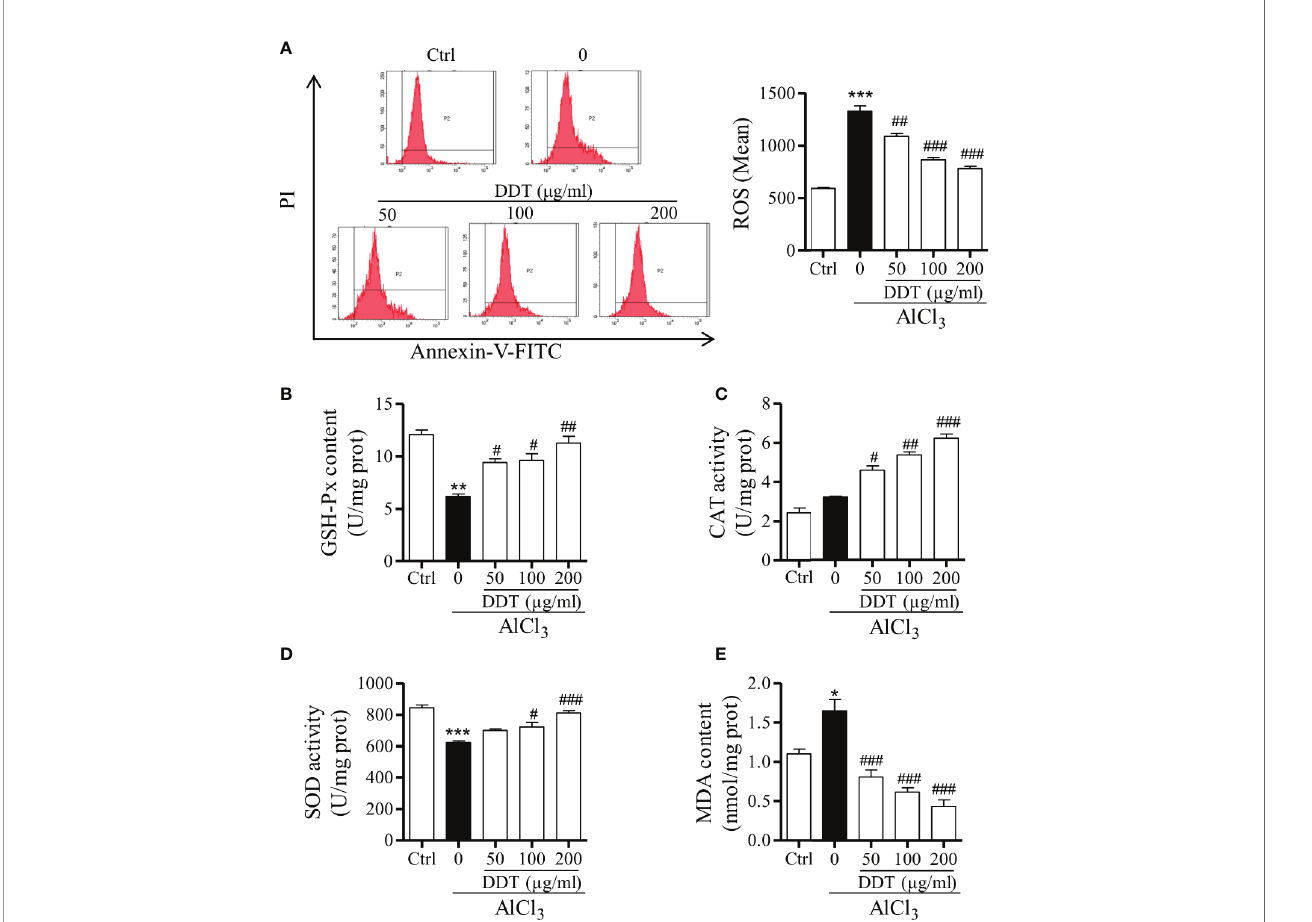
FIGURE 5 | DTT treatment reduces AlCl 3 -induced oxidative stress in PC12 cells. (A) Intracellular ROS levels from PC12 cells pretreated with DDT for 48 h and AlCl 3 induction for 6 h were evaluated by fl ow cytometry. The bar graph on the right shows the fl uorescence intensity of ROS production. (B – E) The effects of DDT on GSH-Px content, CAT, and SOD activities, and MDA content were assessed using biochemical assay kits. Values are means ± standard derivation from three independent experiments. Ctrl: control group. * p < 0.05, ** p < 0.01, *** p < 0.001 vs. control group; # p < 0.05, ## p < 0.01, ### p < 0.001 vs. AlCl 3 -induced model